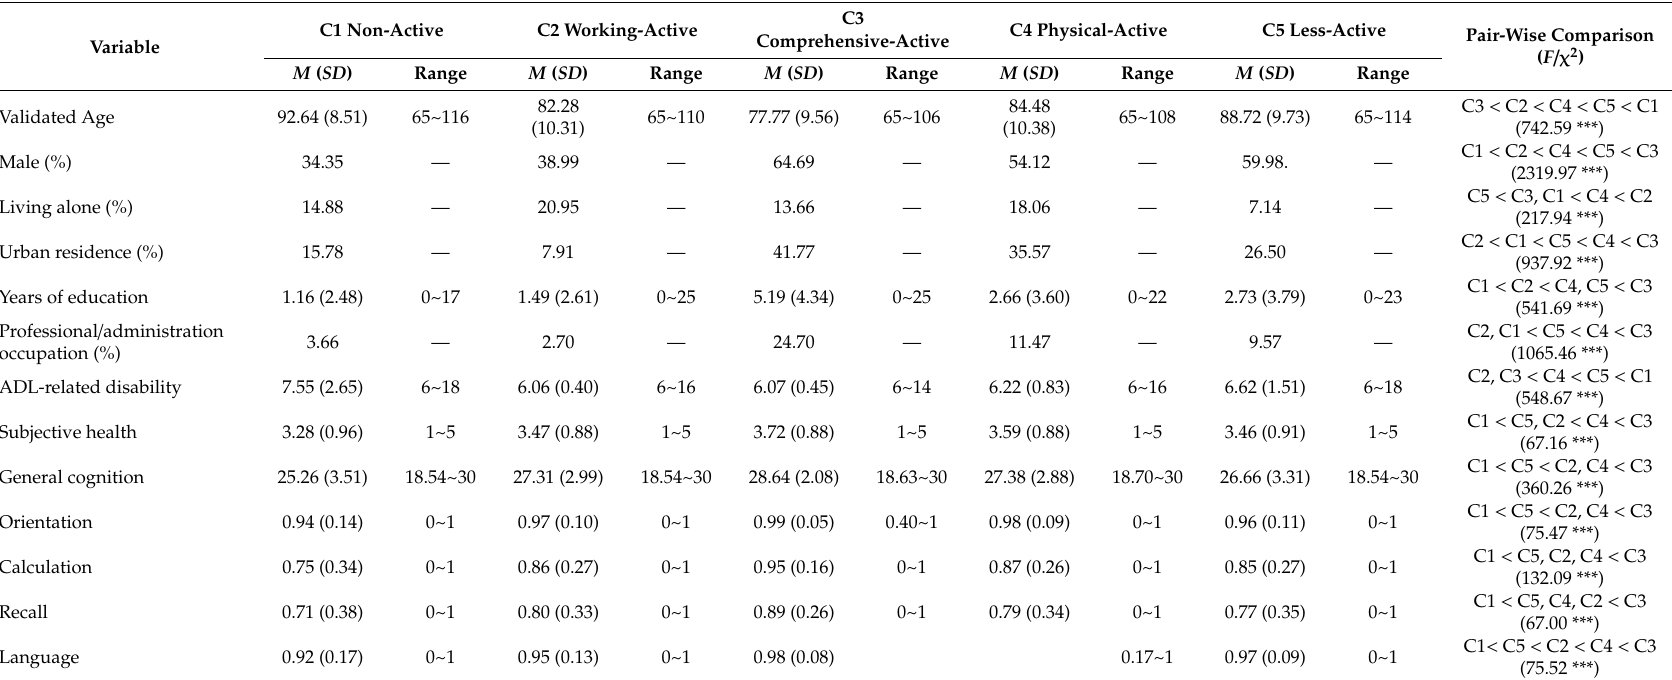
Table 2. Characteristics of Latent Class and Pair-wise